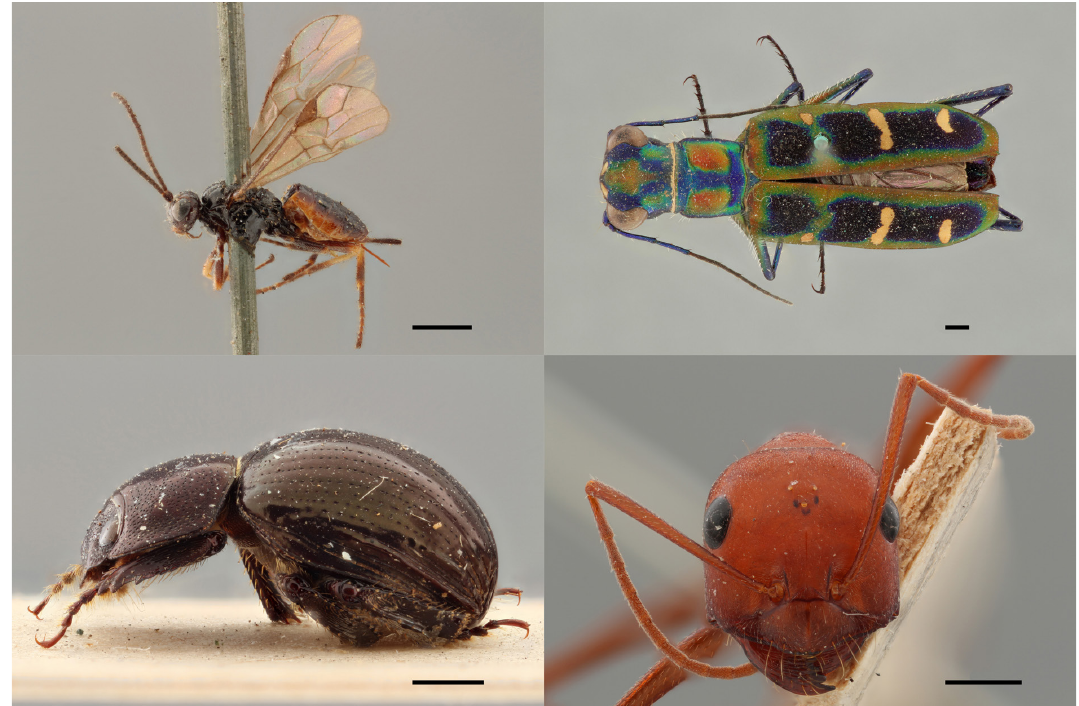
Fig. 2.4. Picturing pinned insects. The pictures represent several insects with highly reflective surfaces positioned in different ways (pinned, upper pictures; glued, bottom pictures). No shadows, no overexposed areas and hardly any reflections are present. Scale = 1 mm.